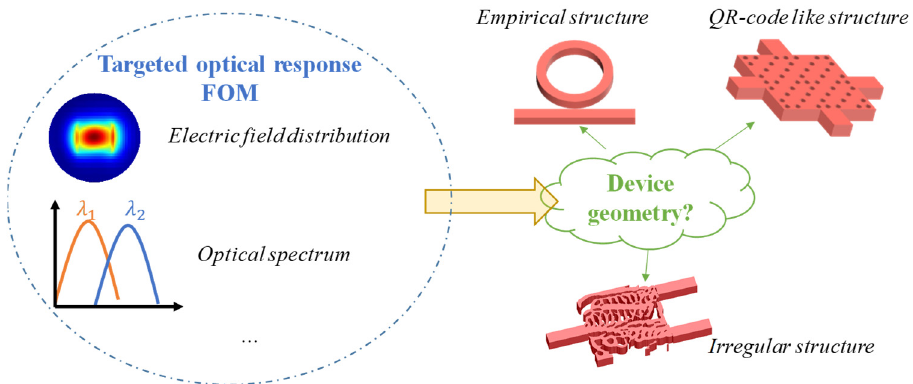
Figure 1. Inverse design schemes for integrated silicon photonics.